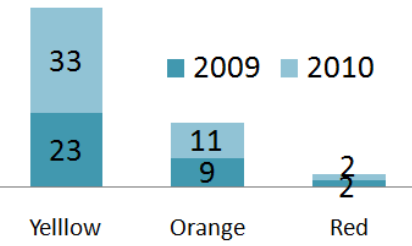
Figure 7. Number of worst warning level colour reached in 2009 and 2010 severe weather episodes. 3